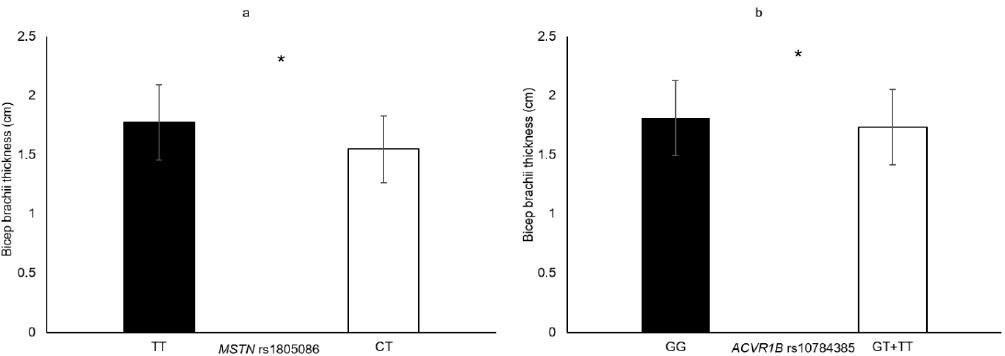
Figure 3. Isometric knee extension maximum voluntary contraction in genotype groups for ( a ) NOS3 rs1799983 (GG = 117 vs. GT + TT = 185, Δ = 7.5%); ( b ) CNTF rs18000169 (GG = 222 vs. AG + AA = 80, Δ = 13.2%). * denotes significant difference. Data are mean ± SD.